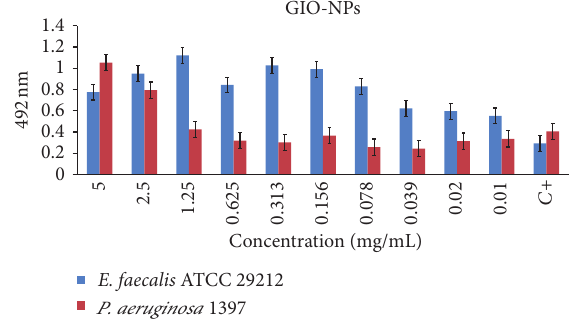
F 3: Infrared transmittance spectra of spectra of GIO-NPs in to 400cm region. the 4000cm −1 −1